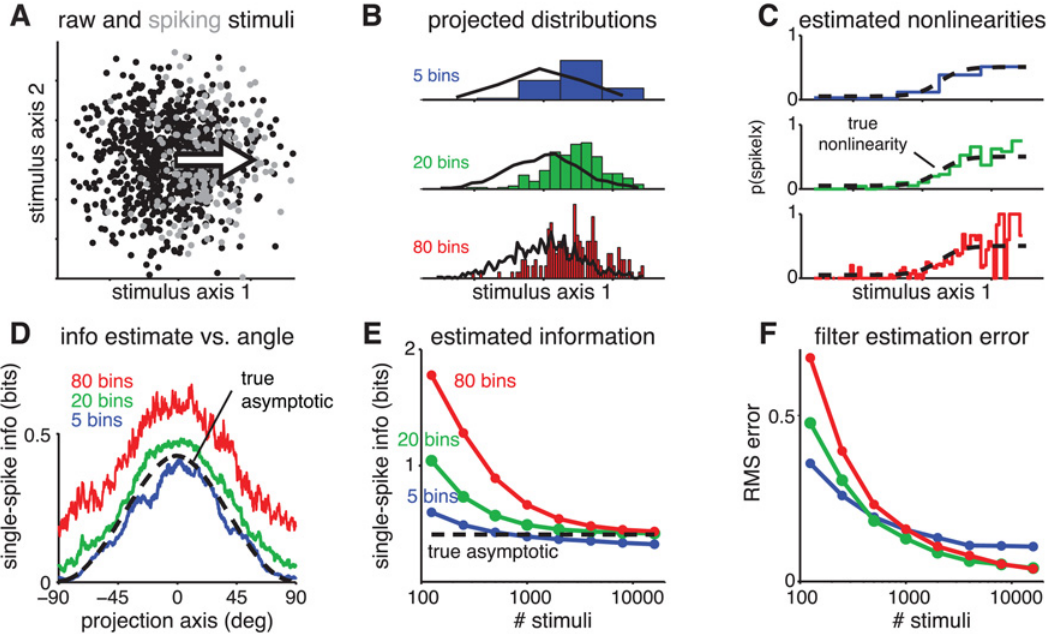
Fig 3. Effects of the number of histogram bins on empirical single-spike information and MID performance. (A) Scatter plot of raw stimuli (black) and spike-triggered stimuli (gray) from a simulated experiment using two-dimensional stimuli to drive a linear-nonlinear-Bernoulli neuron with sigmoidal nonlinearity. Arrow indicates the direction of the true filter k . (B) Plug-In estimates of p ( k > s j spike ), the spike-triggered stimulus distribution along the true filter axis, from 1000 stimuli and 200 spikes, using 5 (blue), 20 (green) or 80 (red) histogram bins. Black traces show estimates of raw distribution p ( k > s ) along the same axis. (C) True nonlinearity (black) and ML estimates of the nonlinearity (derived from the ratio of the density estimates shown in B). Roughness of the 80-bin estimate (red) arises from undersampling, or (equivalently) overfitting of the nonlinearity. (D) Empirical single-spike information vs. direction, calculated using 5, 20 or 80 histogram bins. Note that the 80-bin model overestimates the true asymptotic single-spike information at the peak by a factor of more than 1.5. (E) Convergence of empirical single-spike information along the true filter axis as a function of sample size. With small amounts of data, all three models overfit, leading to upward bias in estimated information. For large amounts of data, the 5-bin model underfits and therefore under-estimates information, since it lacks the smoothness to adequately describe the shape of the sigmoidal nonlinearity. (F) Filter error as a function of the number of stimuli, showing that the optimal number of histogram bins depends on the amount of